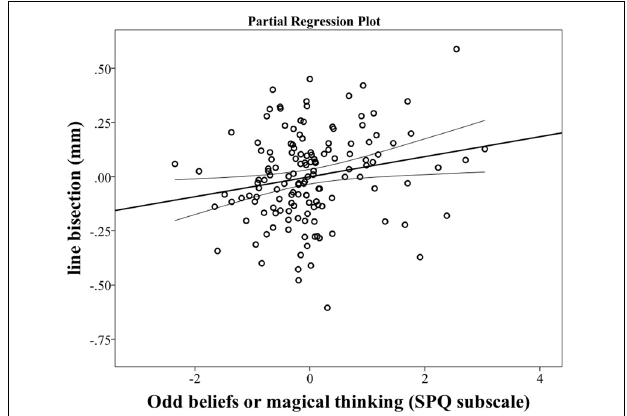
FIGURE 1 | The line bisection (LB) index was independently predicted by “Odd beliefs or magical thinking” SPQ scale ( p < 0 . 0001, β = 0 . 273). In the figure, the partial regression plot a , b outlines the single relation between the “Odd Beliefs or Magical Thinking” subscale score (independent predictor) and LB index (dependent variable). a This plot shows the real and specific effects of one independent predictor (“Odd Beliefs or Magical Thinking”) on dependent variable (LB), controlling (or regressed) independently for the other predictor. More in detail, the scatterplot (based on least squares fitting) displays the residuals (or errors: correspond to unexplained or residual variation between the observed values of the variable and the values suggested by the regression model) of each independent predictor variable and the residuals of the dependent variable, after the effect of other predictor has been removed separately on the two variables. b Bold line is the fit line, representing the trend of the data. This linear regression (based on least squares method) line fits, in the best way, all the data points in the graphs. Thin lines show the CI 95 for mean.